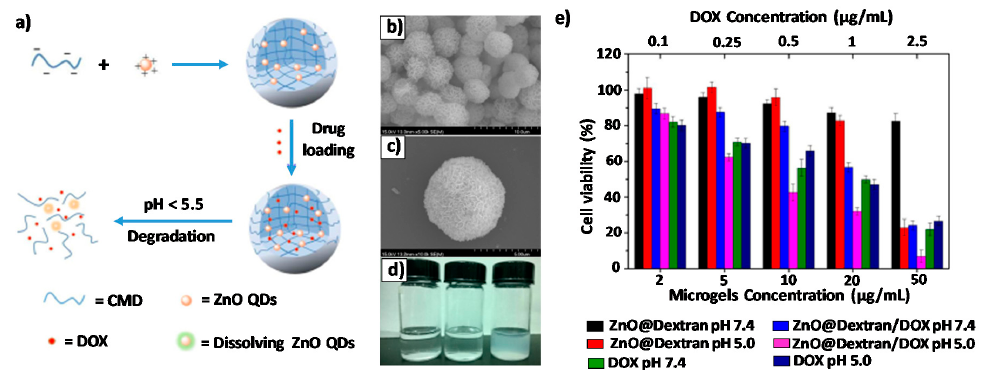
Figure 6. ( a ) Schematic representation of fabrication and degradation process of the ZnO@Dextran microgels; ( b , c ) Two different magnification SEM photographs of ZnO@Dextran microgels; ( d ) Digital photos of ZnO@Dextran microgels after incubation at pH 3.0 (left), 5.0 (middle) and 7.4 (right); ( e ) Cell viabilities of HeLa cells after being incubated with different samples under different conditions.